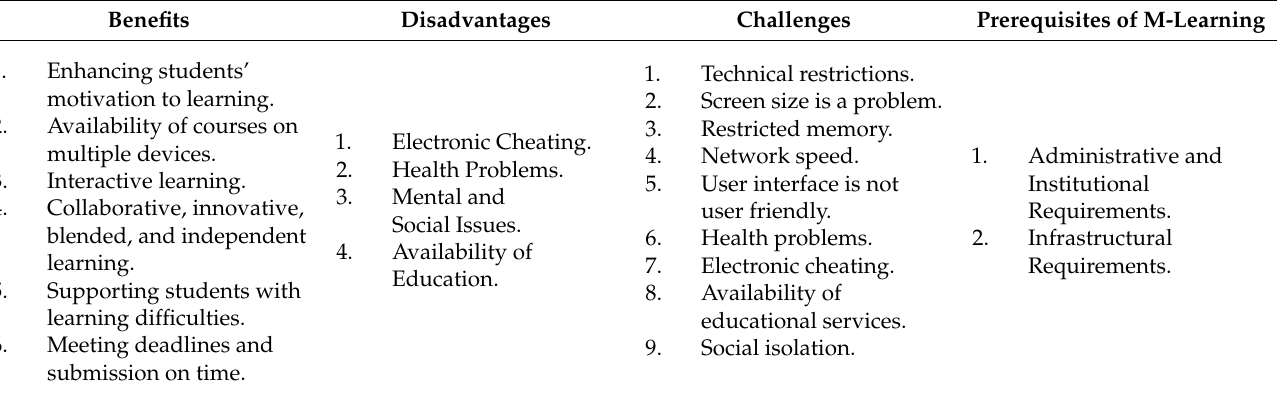
Table 1. Qualitative Results: Benefits, drawbacks, challenges, and prerequisites of m-learning. Benefits Disadvantages Challenges Prerequisites of